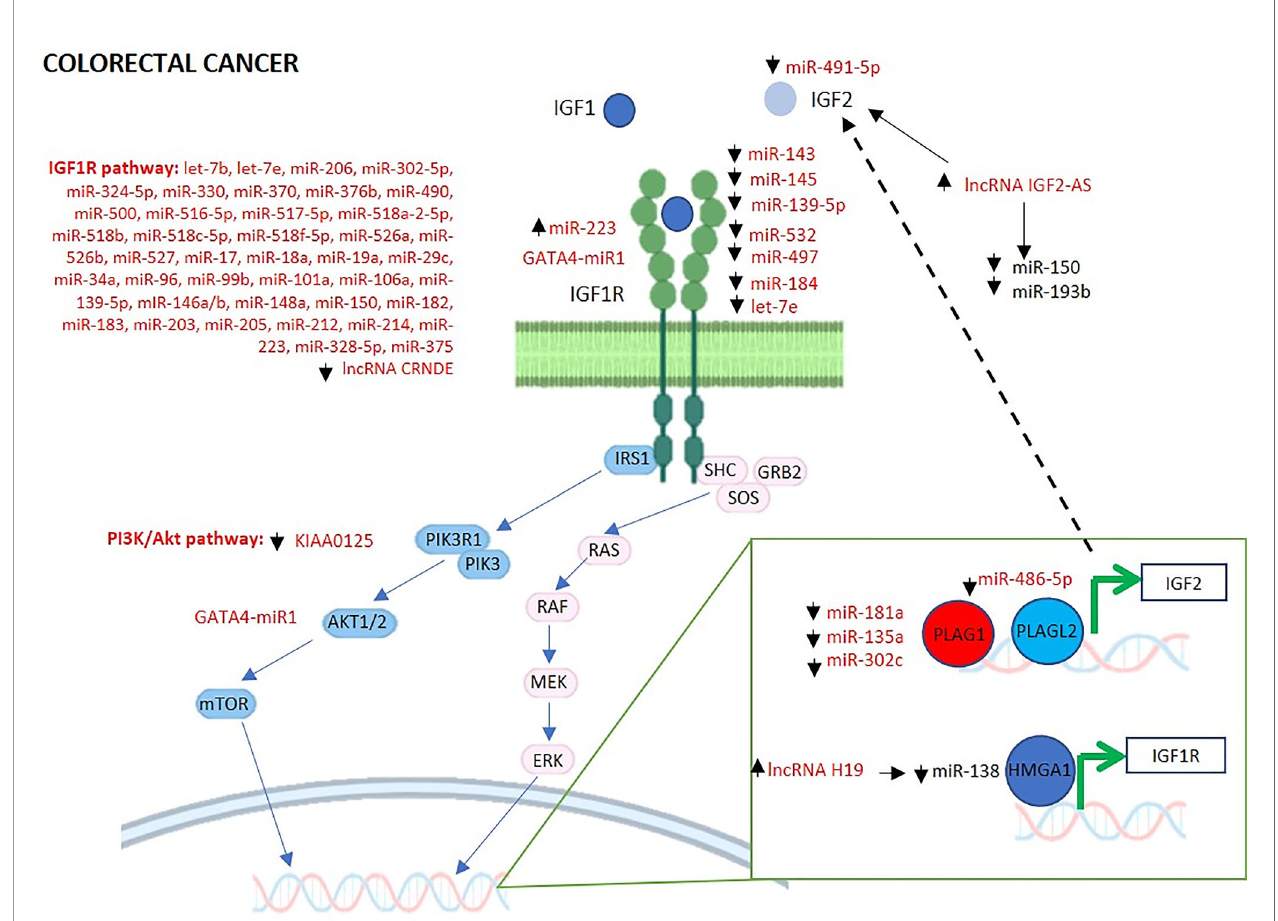
FIGURE 3 | MiRNAs and lncRNAs regulating IGF signaling in colorectal cancer. The schematic cartoon describes current knowledge relative to the interactions among miRNAs, lncRNAs and their targets within the GH and IGF1 signaling pathways in the context of colorectal cancer. The miRNAs and lncRNAs known to interact directly with their targets are reported in red. HMGA1, High Mobility Group AT-Hook 1; PLAG1, PLAG1 Zinc Finger; PLAGL2, PLAG1 Like Zinc Finger 2; IGF1, Insulin Like Growth Factor 1; IGF2, Insulin Like Growth Factor 2; IGF1R, Insulin Like Growth Factor 1 Receptor; IRS1, Insulin Receptor Substrate 1; PIK3R1, Phosphoinositide-3-Kinase Regulatory Subunit 1; PIK3, phosphoinositide 3-kinase; AKT1/2, AKT Serine/Threonine Kinase 1/2; mTOR, mammalian target of rapamycin; SHC, Src Homology 2 Domain-Containing protein; GRB2, Growth Factor Receptor Bound Protein 2; SOS, Son of sevenless Ras/Rac Guanine Nucleotide Exchange Factor; RAS, rat sarcoma protein; RAF, Raf Proto-Oncogene, Serine/Threonine Kinase; MEK, Mitogen-Activated Protein Kinase Kinase; ERK, extracellular signal-regulated